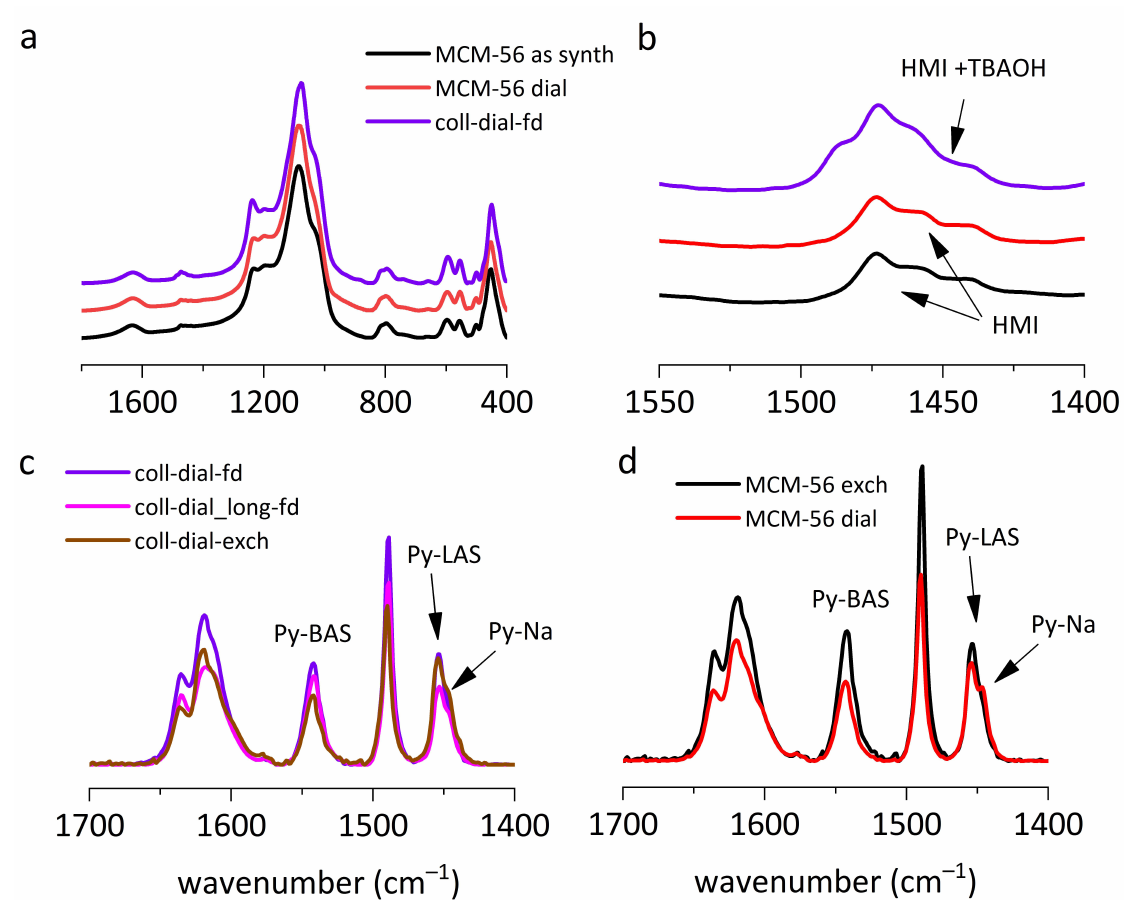
Figure 6. ( a ) Effect of dialysis on sodium, hexamethylene imine (HMI) and tetrabutylammonium hydroxide (TBAOH) content: IR spectra in KBr technique for dialyzed zeolites: MCM-56 as synthesized, MCM-56 dialyzed, and coll-dial-fd, ( b ) the spectra presented in ( a ) in the region of C-H and C-N vibrations characteristic of HMI and TBAOH, ( c ) effect of dialysis and ion exchange: IR spectra of pyridine adsorbed on colloids dialyzed for different times (coll-dial-fd and coll-dial_long-fd) and on sample ion exchanged after dialysis (coll-dial-exch), ( d ) effect of dialysis on reference MCM-56 zeolite: IR spectra of pyridine adsorbed on MCM-56 ion-exchanged and dialyzed